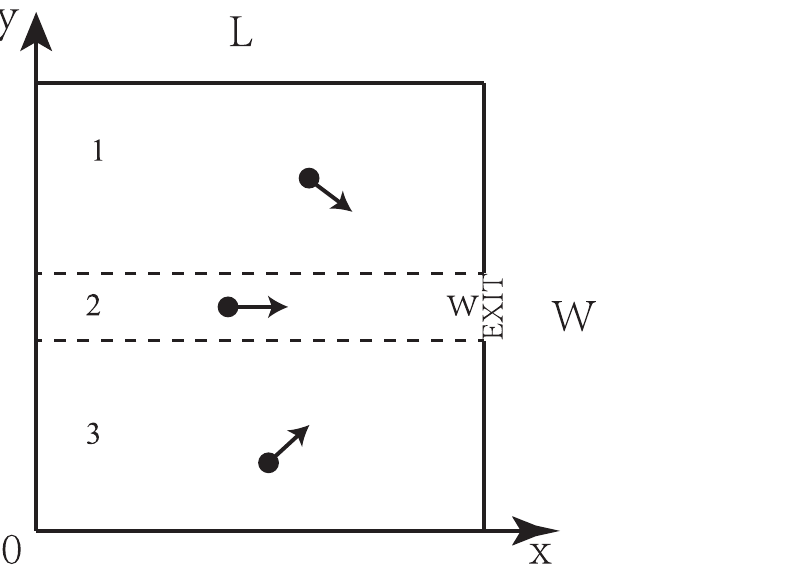
Fig 1. Schematic presentation of the different regions in the